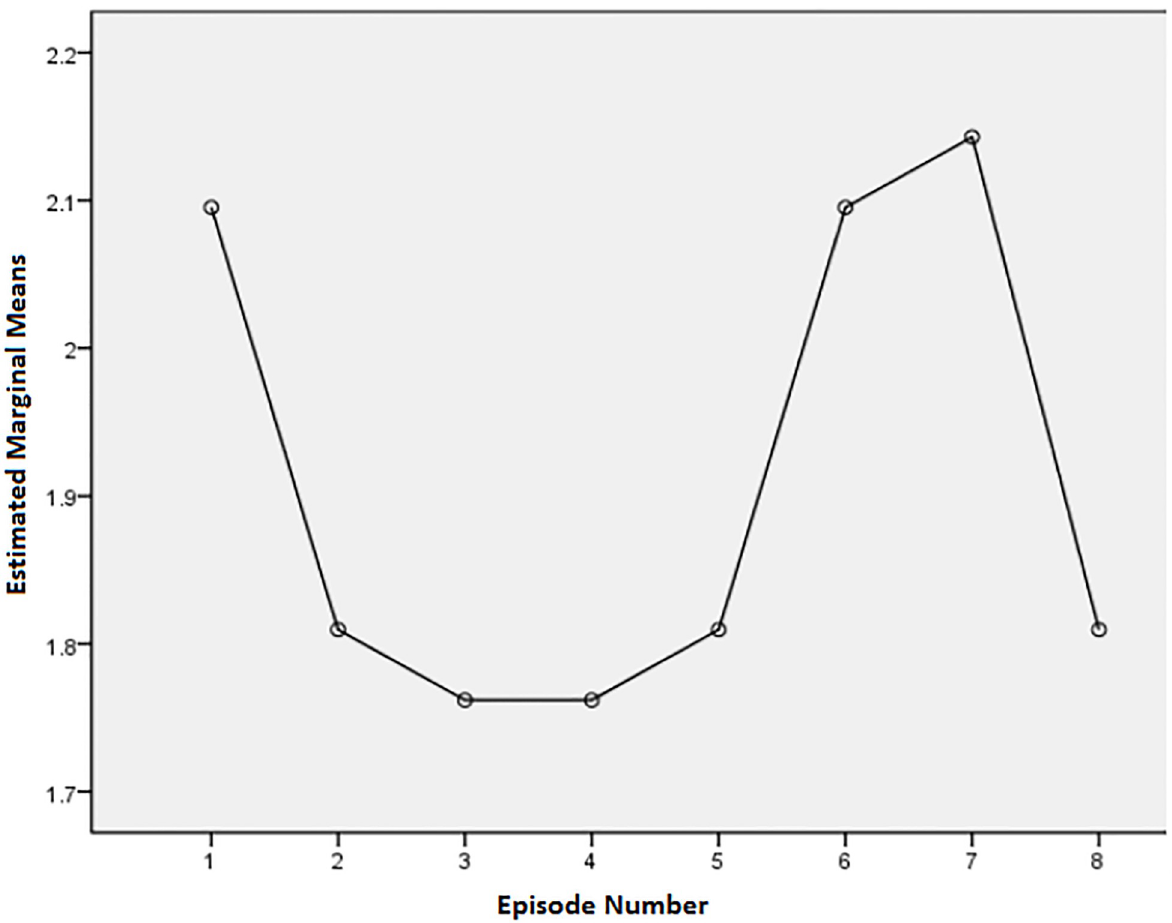
Fig 1. Means plot for enjoyment of show ratings (1 is very enjoyable and 5 is not enjoyable at all).